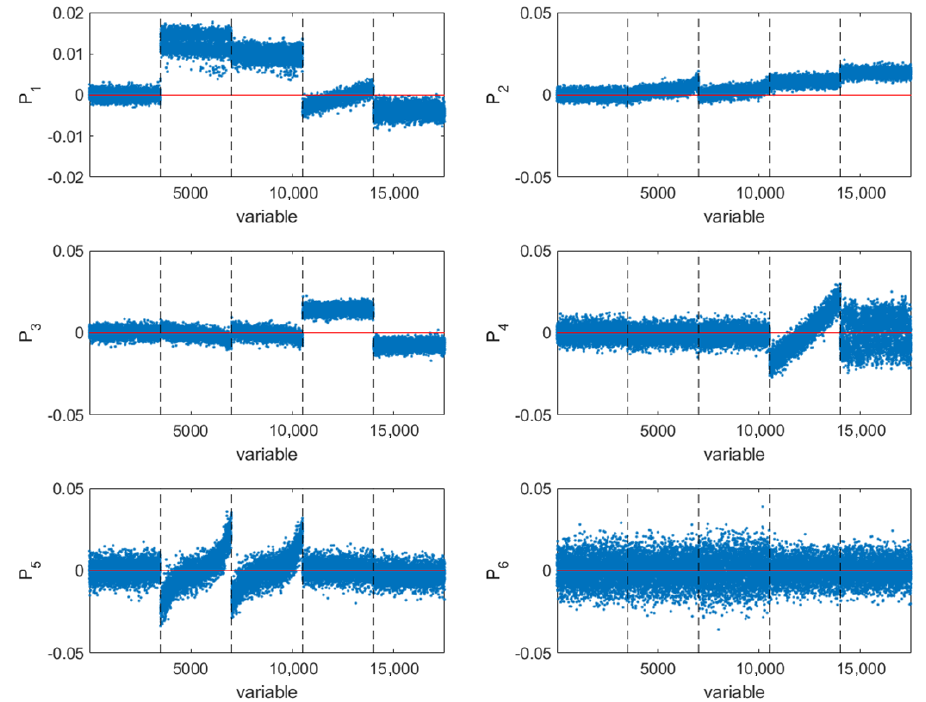
Figure 8. Loadings of the first six principal components. Each block of loadings corresponds to (from left to right) areas, heights, volumes, offset-X and offset-Y.